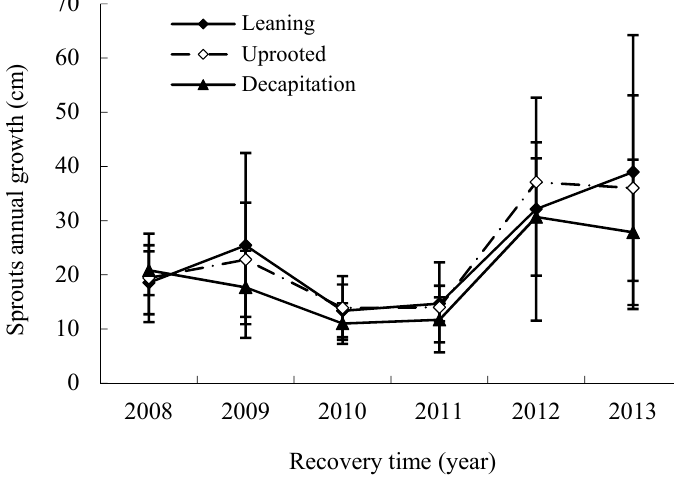
Figure 6. The annual change of mean total sprout biomass per tree for three damaged Figure 5. The annual change of sprouts new growth for three damaged types of trees.